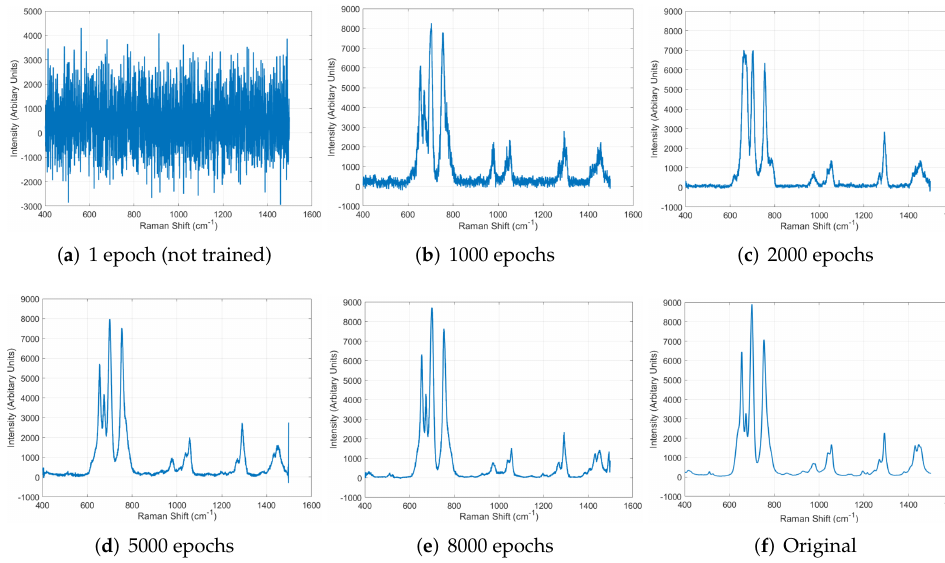
Figure 7. Raman spectrum data generated by GAN as the training progressed and original